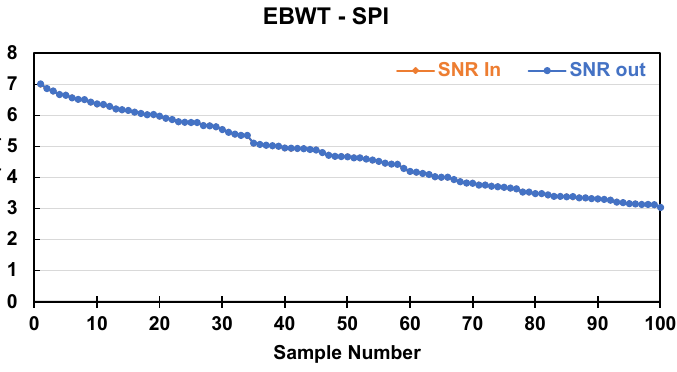
Figure 24. SNR of 100 samples of PD signals contaminated with SPI. The maximum ∆ SNR = 10.8 dB and the minimum = 7.7 dB. The average ∆ SNR = 9.4 dB.